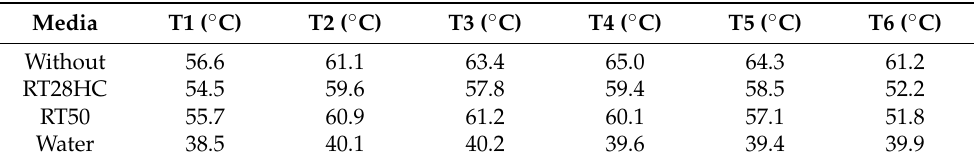
Table 5. Comparison of absolute temperature in channels during the end of the experimental duration; location of channels given in Figure